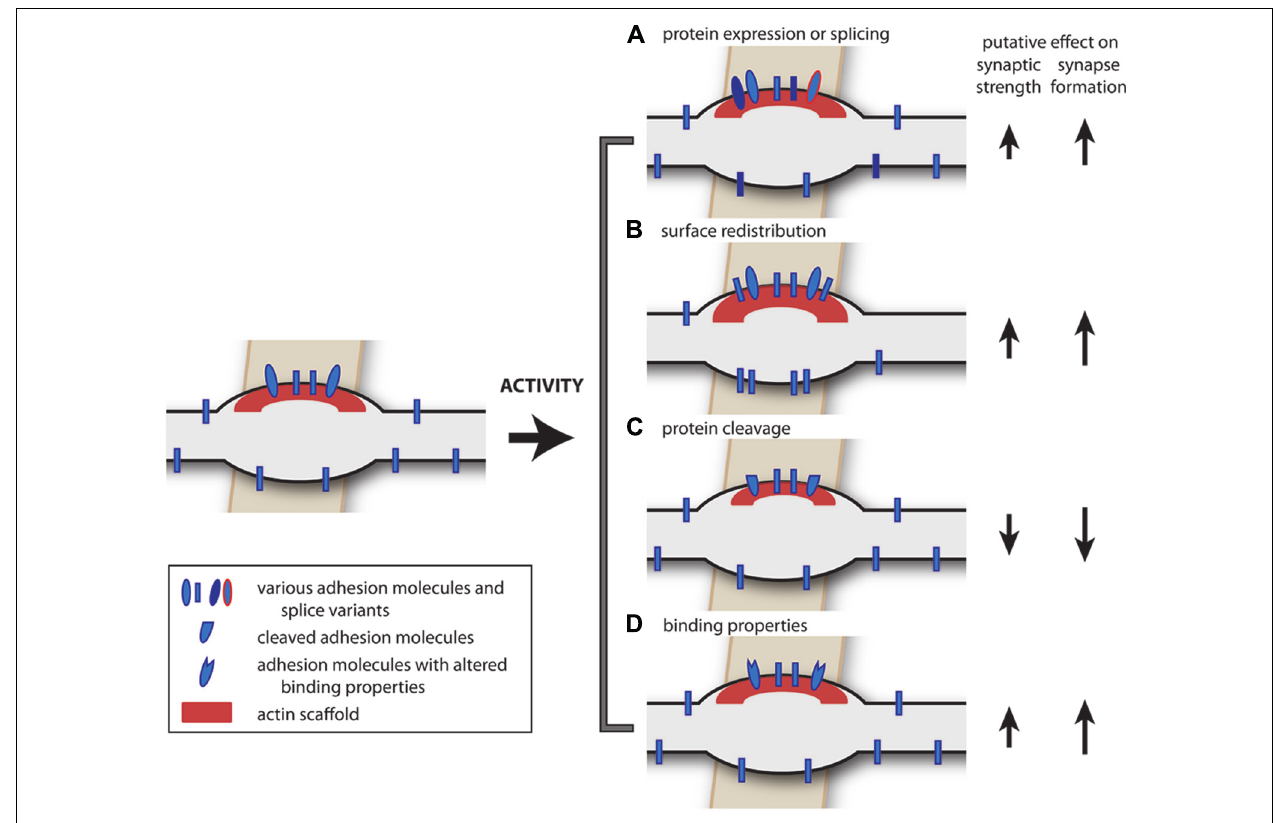
synapse formation (Fu and Huang, 2010). (C) Activity-dependent cleavage of synaptic adhesion molecules could induce synapse disassembly or plasticity (Matsumoto-Miyai etal., 2009; O’Connor etal., 2009; Peixoto etal., 2012; Suzuki etal., 2012). (D) Activity-dependent changes in binding properties of adhesion molecules (Kim etal., 2011a,b) could affect synaptic properties. In addition, the intracellular signaling pathways (not depicted) may also be regulated in an activity-dependent manner, affecting all of these